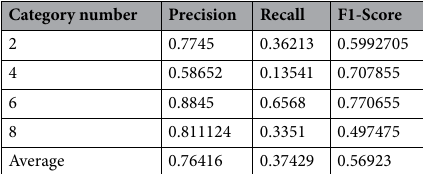
Table 4. Category based